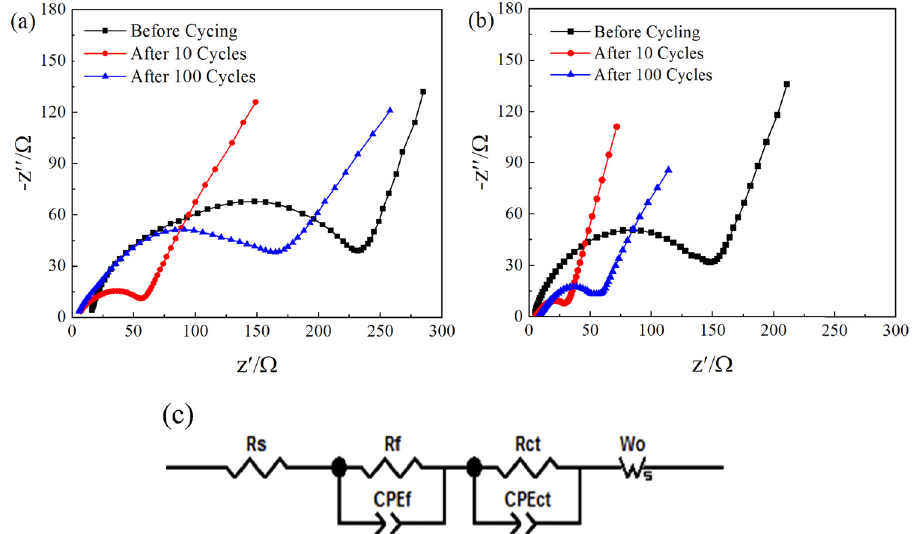
Figure 12: Nyquist plots of ( a ) pristine and ( b ) ZnO - coated LiNi 0.8 Co 0.15 Al 0.05 O 2 samples after di ff erent cycles, ( c ) equivalent circuit